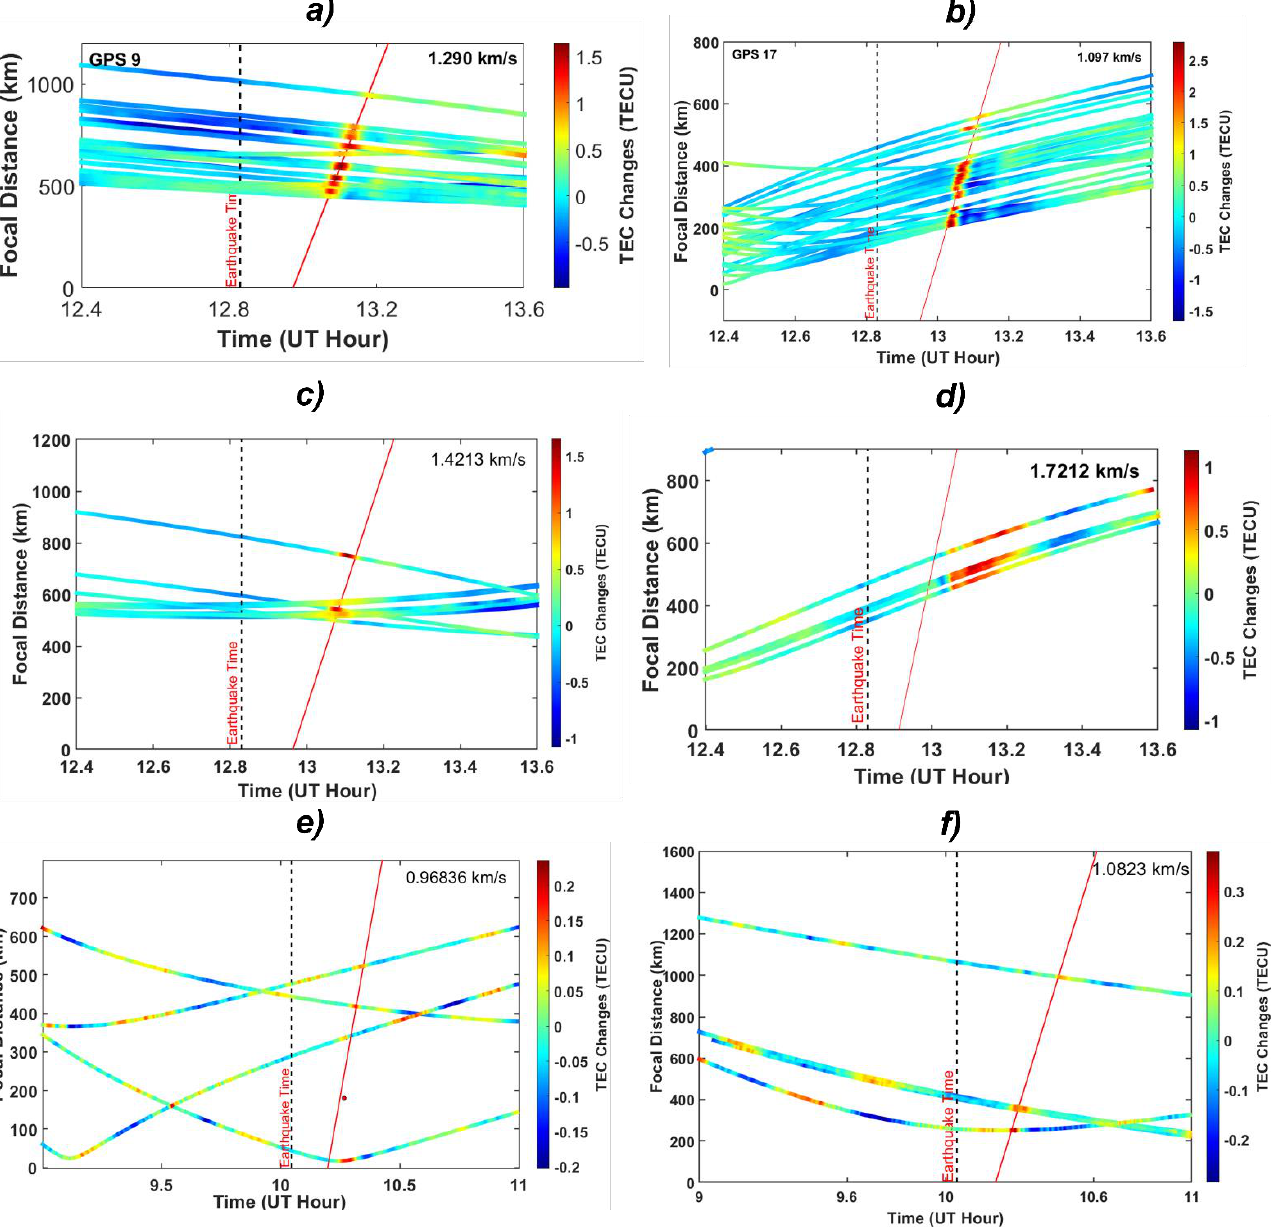
Figure 4. CID speed as observed from GPS PRN 9 ( a ), 17 ( b ), 23 ( c ), and GLONASS PRN 4 ( d ) of the 2016 West Sumatra earthquake is about 1.29 ± 0.013 km s − 1 , 1.10 ± 0.014 km s − 1 , 1.42 ± 0.168 km s − 1 , and 1.72 ± 0.53 km s − 1 , respectively, and also the travel-time diagram of the 2018 Palu earthquake CID based on GPS PRN 21 ( e ) and 25 ( f ) are 0.97 ± 0.191 km s − 1 and 1.08 ± 0.039 km s − 1 , respectively. Distances are measured from the epicenter. The black vertical dash line indicates the occurrence of the 2016 West Sumatra earthquake (12:49 UT) and 2018 Palu earthquake (10:02:45 UT). The Pearson’s correlation of CID slip as observed from GPS PRN 9, 17, and 23 and GLONASS PRN 4 are about 0.97, 0.94, 0.77, and 0.73, respectively. On the other hand, GPS PRN 21 and 25 are 0.93 and 0.99, respectively.